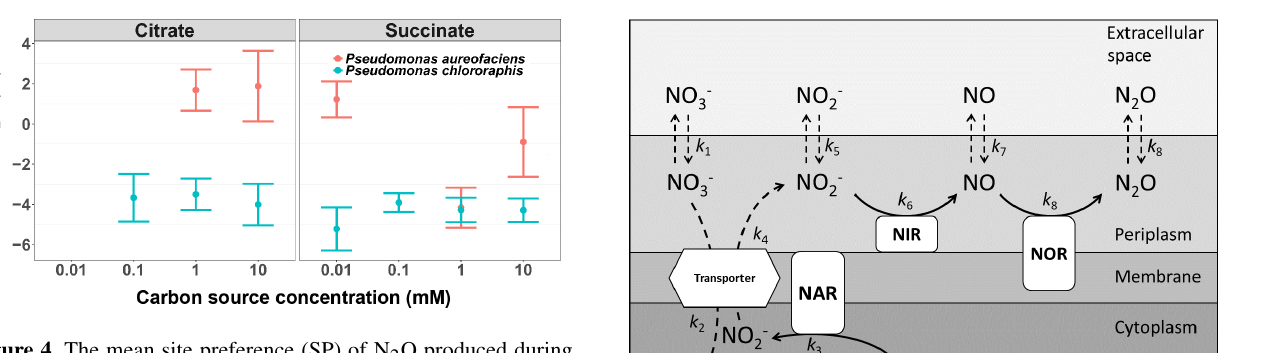
Figure 4. The mean site preference (SP) of N 2 O produced during the reduction of NO − by Pseudomonas aureofaciens (orange) and 3 Pseudomonas chlororaphis (blue) with different concentrations of electron donors: citrate and succinate. Error bars indicate 1SD. Figure 5. A schematic representation of the multi-step reduction of nitrate to nitrous oxide during denitrification specific to Pseu- domonas aureofaciens and Pseudomonas chlororaphis , which lack the enzyme nitrous oxide reductase. The enzymes responsible for the reduction of nitrogen species appear in boxes with rounded cor- ners and are indicated by three letter sequences: nitrate reductase (NAR), nitrite reductase (NIR) and nitric oxide reductase (NOR). A nitrate/nitrite transporter protein is presented as a hexagon. The position of the enzymes with respect to the periplasm, membrane or cytoplasm identifies the location of the enzymes in the cell. Ver- tical dashed arrows indicate diffusion of various nitrogen species into and out of the cell, and curved dashed arrows represent trans- port across the membrane. Solid arrows represent enzyme-catalyzed reduction